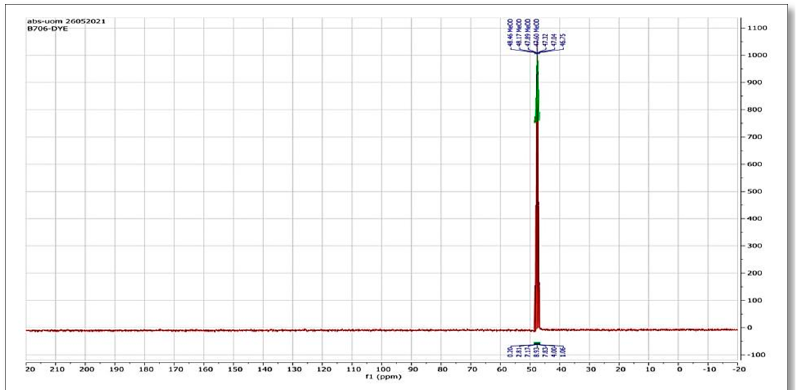
Figure 11. Original Dye Brown 706 1 H NMR.